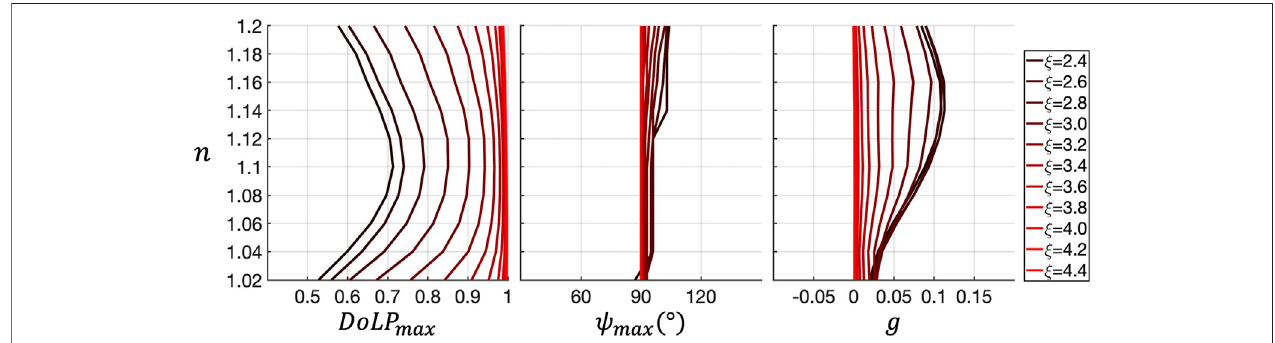
FIGURE 4 | Particulate refractive index n plotted against the three DoLP shape parameters of the asymmetric hexahedral DoLPs, same as Figure 2 .